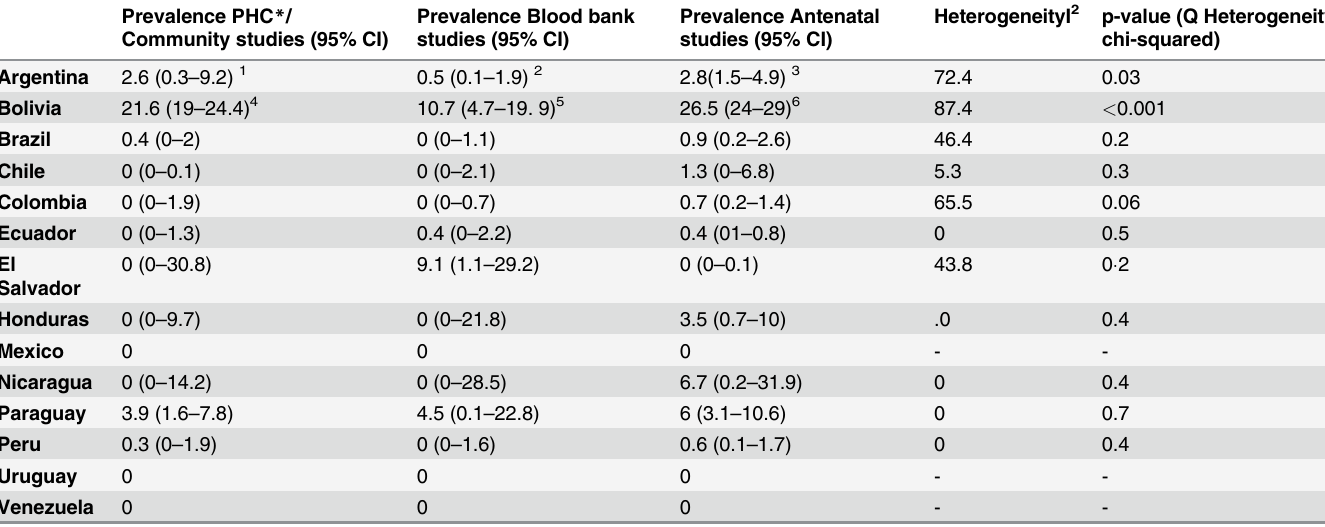
Table 3. Country-speci fi c prevalence of Chagas disease by type of study and values of results of heterogeneity tests among different type of studies. Prevalence PHC * / Community studies (95%